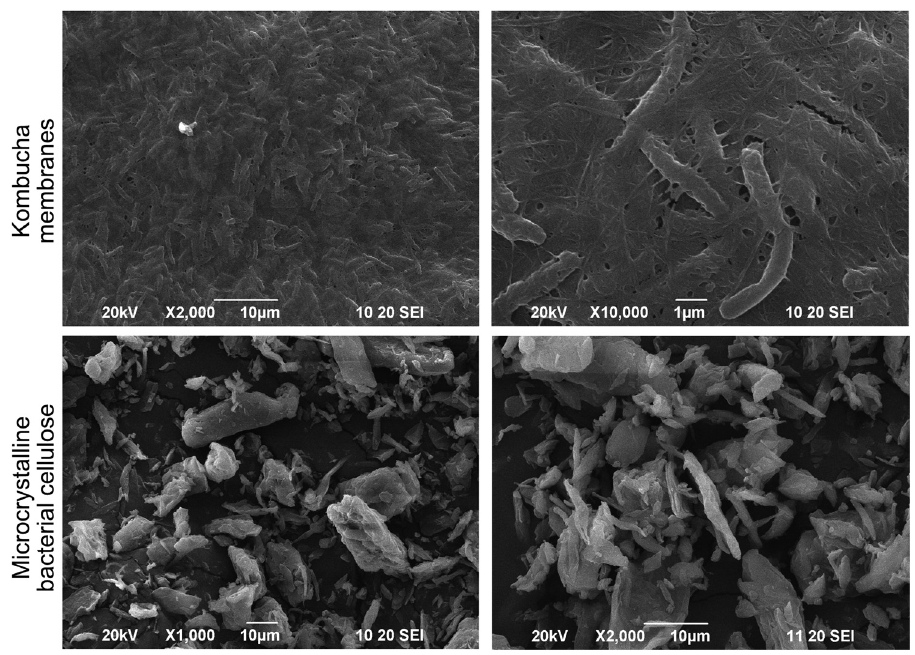
Figure 6: Scanning electron microscopy of kombucha membranes and microcrystalline bacterial